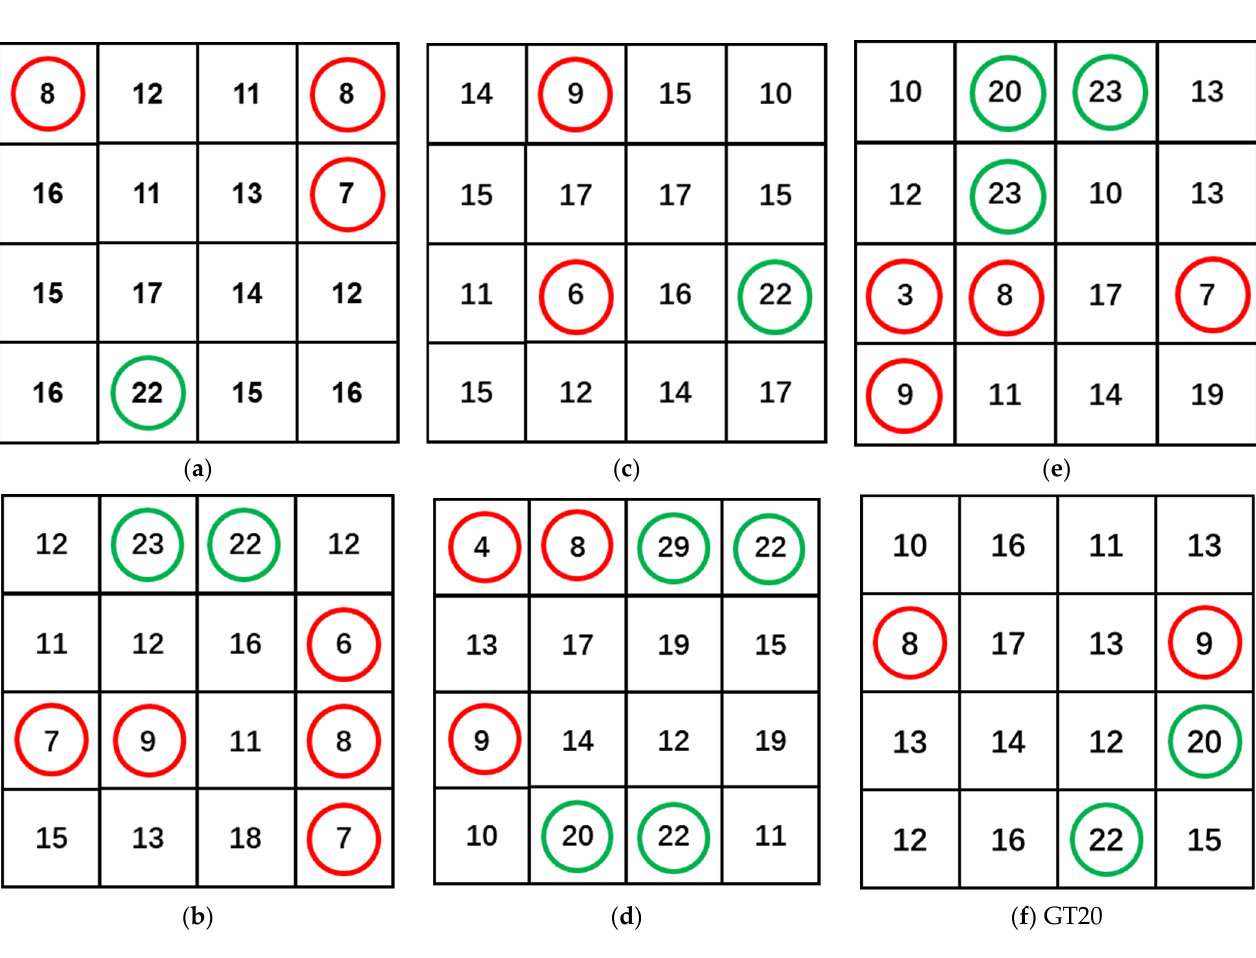
Figure 23. Simplified diagram of the number of cross-section steel fibers. ( a ) GT00 Left section ( b ) GT00 Right section; ( c ) GT10 Left section; ( d ) GT10 Right section; ( e ) GT20); ( f ) GT20 Right section.